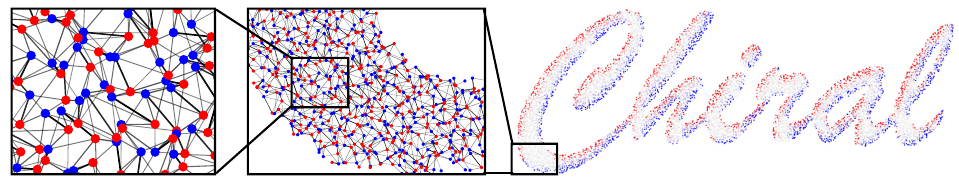
Figure 8: Disordered chiral metamaterial Macroscopic view and close ups on an amorphous frame supporting a disordered chiral insulator. The frame is defined adding a strong positional disorder to a Honeycomb lattice | δ x | = a . Using the same Hamiltonian as in Figs.6 and 7, we add spectral disorder corresponds to ε ting the sample to form the word ”chiral” reveals a continuous distribution of zero modes along the